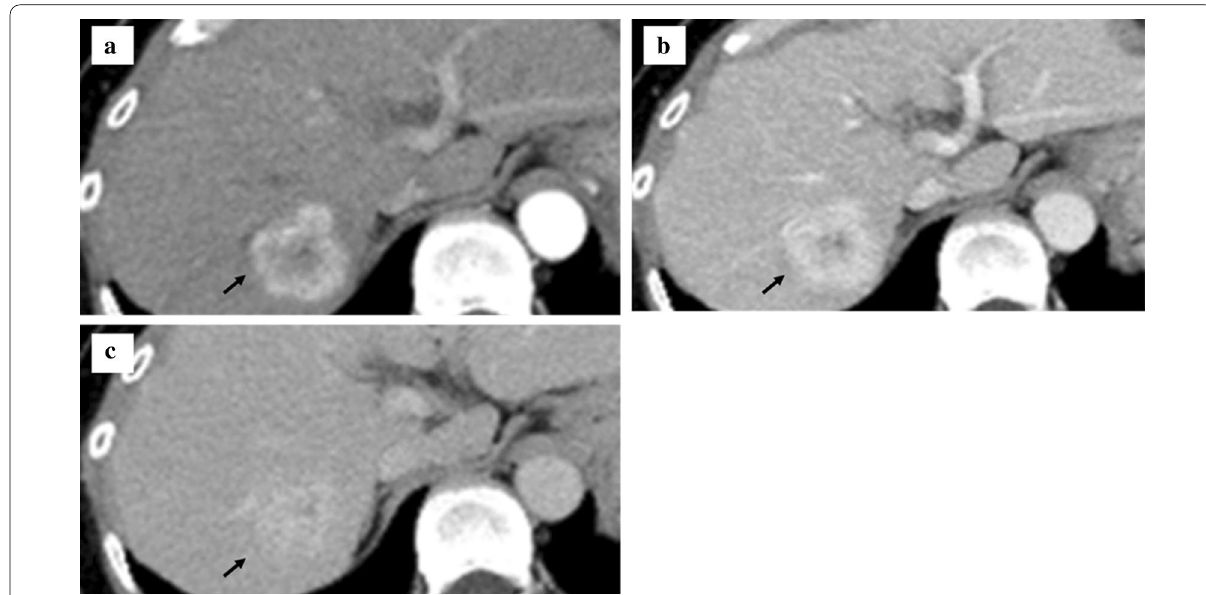
Fig. 1 Findings of dynamic abdominal computed tomography. a The arterial phase showing a ring-like enhanced mass at segment 7 measuring 35 mm in diameter shaped like an irregular arrow. b Portal phase. c The enhancement was prolonged to the late